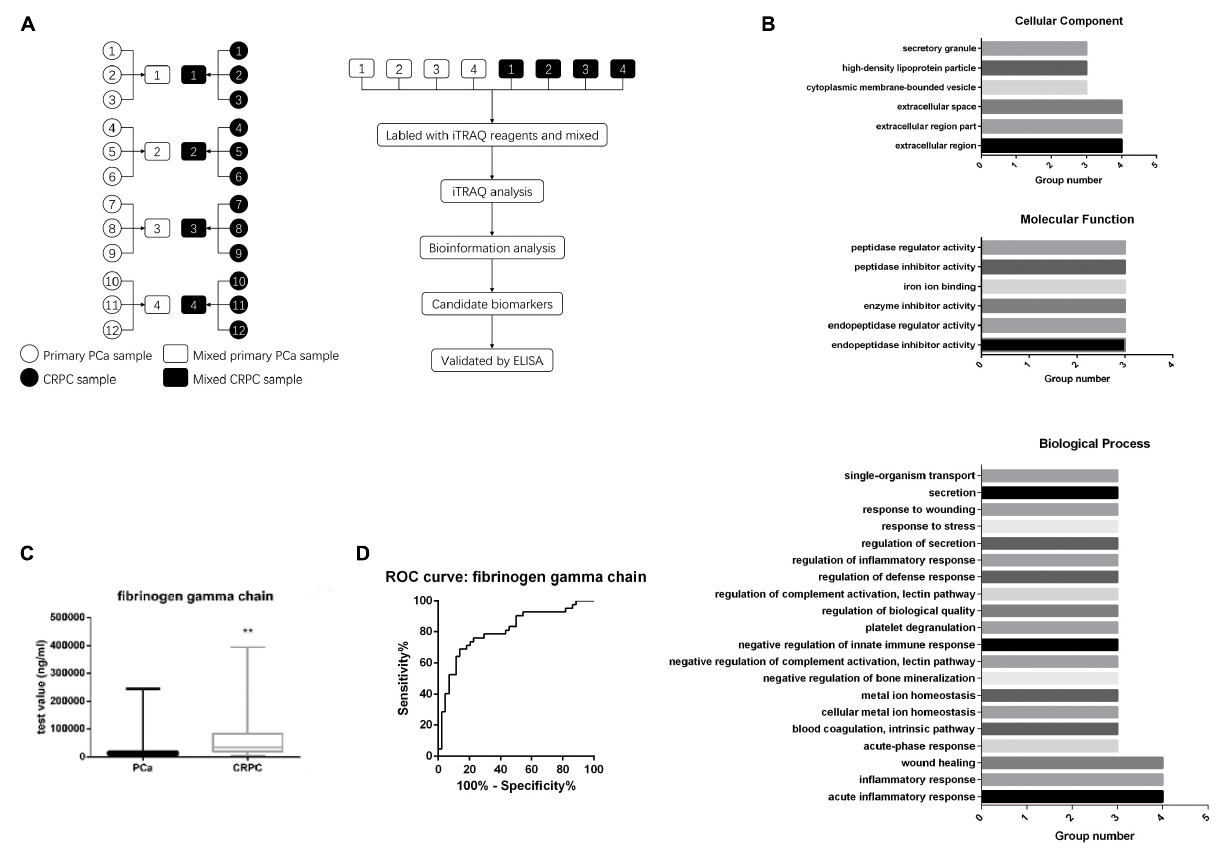
FIGURE 1 | Serum FGG levels in CRPC patients are higher than patients with localized PCa. (A) Twelve patients were divided into four groups. Their serum was collected at both the primary PCa stage and when it has progressed to CRPC. Serum protein levels were analyzed with iTRAQ. (B) GO enrichment and KEGG pathway enrichment analyses for the differentially expressed genes. (C) Serum FGG levels in CRPC is higher than that of localized PCa. (D) Sensitivity and specificity of the ROC curve for using serum FGG as a diagnostic for CRPC. ** p <